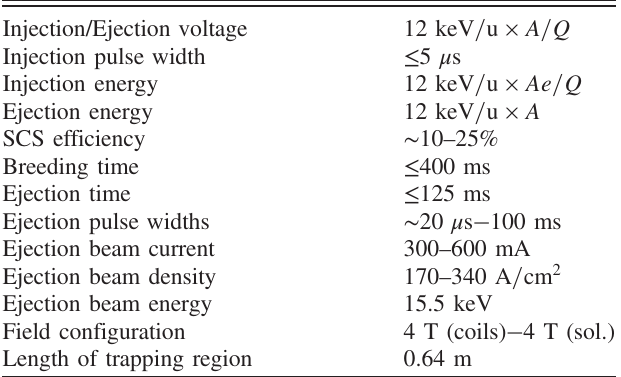
TABLE I. Typical ReA EBIT operational parameters employed for reacceleration of beams to experiments. “ SCS efficiency ” stands for the charge-breeding efficiency in single charge states. A and Q are the mass and charge of the reaccelerated ion in units of u and e, respectively. The electron-beam current density was estimated from the electron-beam radius measured by x-ray imaging (see Sec. II